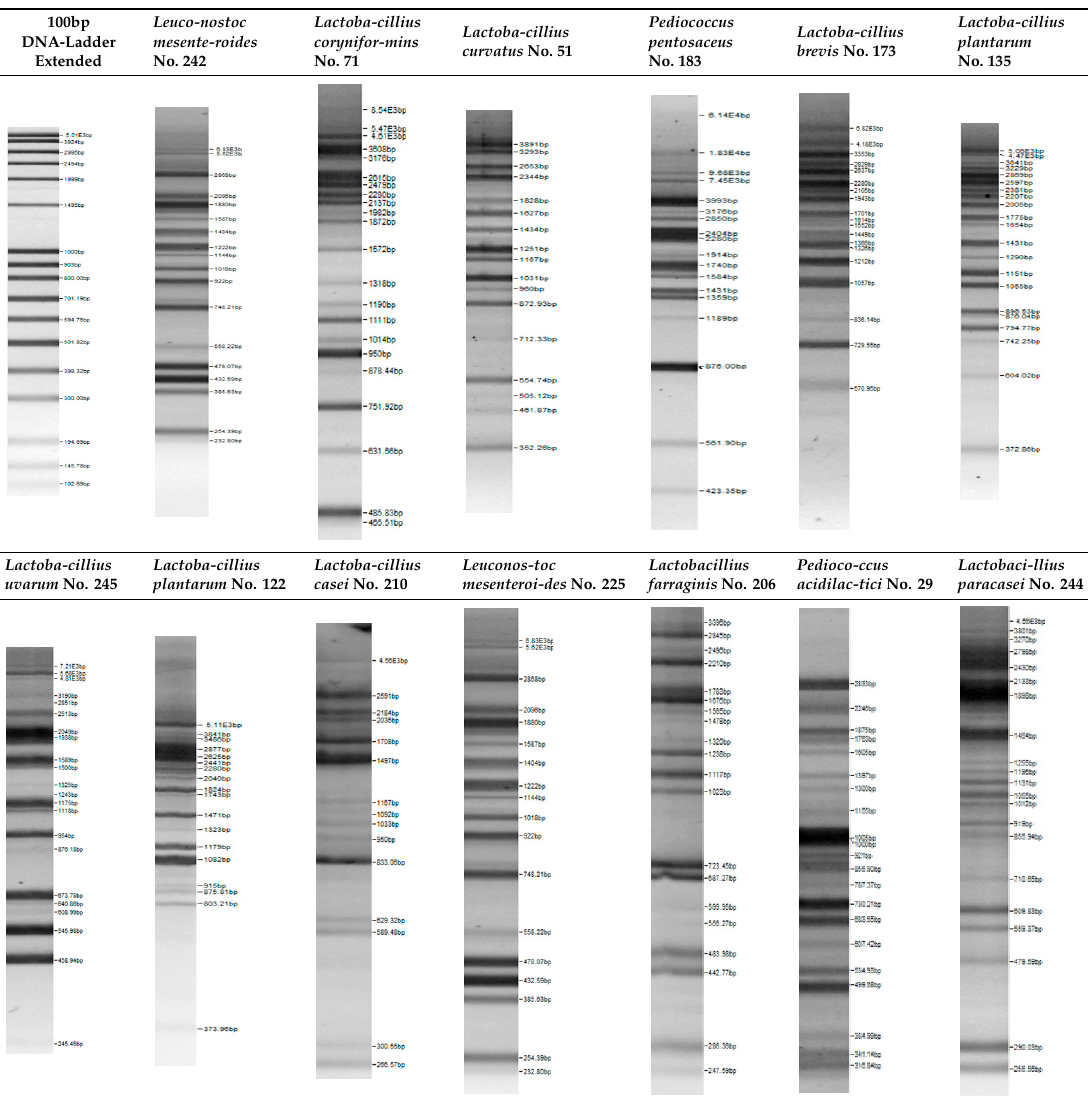
Table 2. Bands of the isolated LAB genus (analyzed by the BioNumerics v4.0 software package). 100bp DNA-Ladder